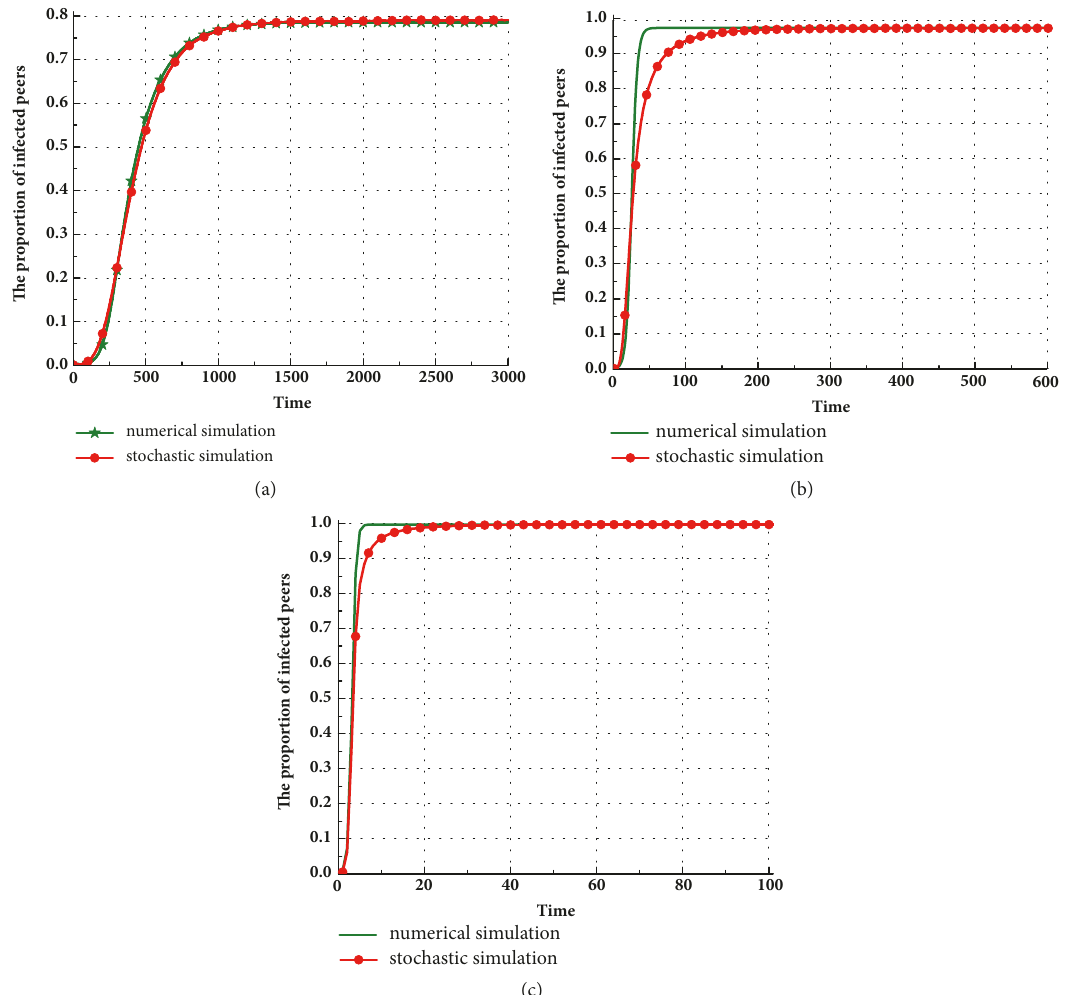
Figure 2: The numerical simulations and the stochastic simulations with different 𝑑 . (a) d=1; (b) d=2; (c)